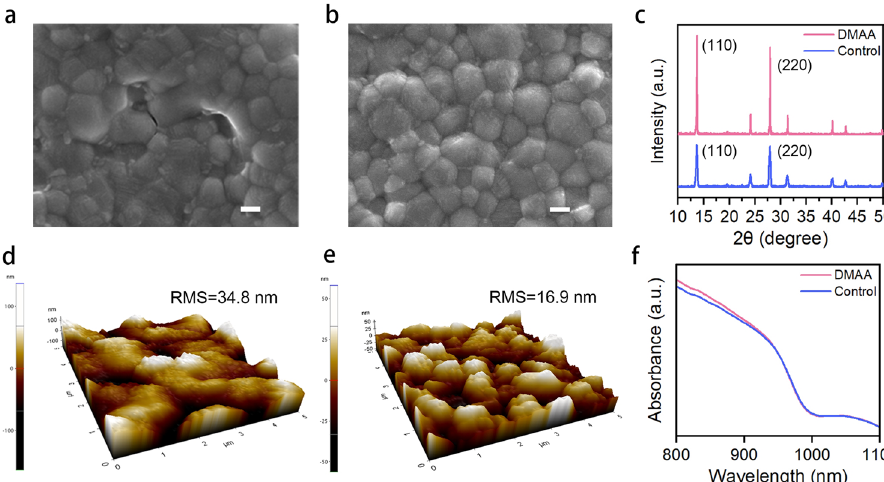
Fig. 1 Morphology, structure, and optical properties of perovskite fi lms. SEM images of perovskite fi lms ( a ) without and ( b ) with DMAA, and the scale bar is 100 nm. c XRD patterns of perovskite fi lms. AFM images of perovskite fi lms ( d ) without and ( e ) with DMAA. f UV – vis absorption spectra of perovskite fi lms.